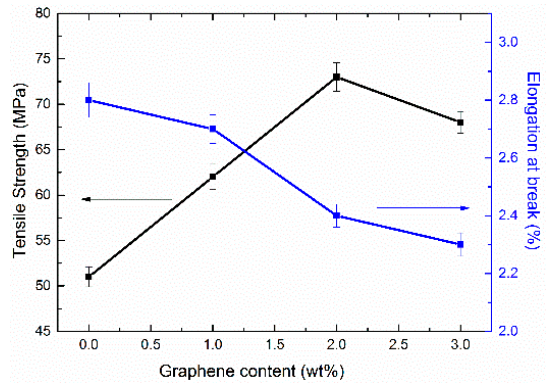
Figure 2. Tensile properties of the graphene/H-EP composites.